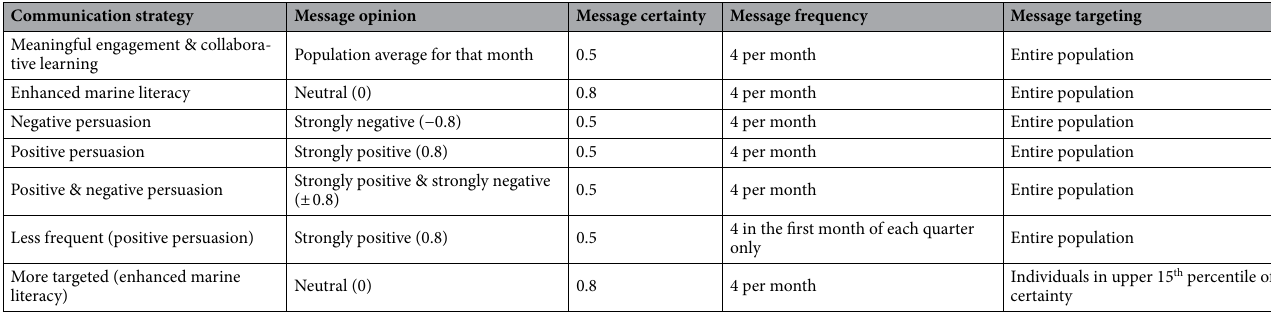
Table 2. Definition of communication strategies tested within SIEM. Parameters not defined here were as in Table 1, with messaging assumed to reach 0–40% of the population (i.e. same range as newspaper